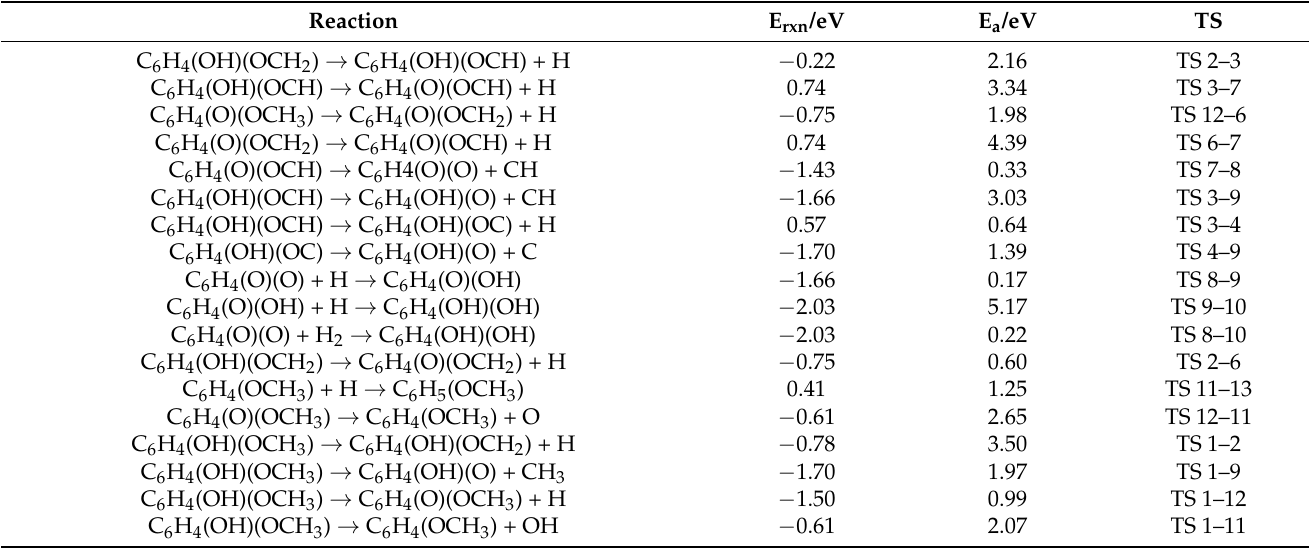
Figure 3. The four reaction paths (A, B, C, and D) and networks considered for the conversion of guaiacol to catechol and anisole. * indicates on the adsorbate, the sites of decomposition and radical formation. Table 1. Chemical equations for the elementary reaction steps involved in the HDO reaction of guaiacol, the transition state structures, and the single imaginary frequencies for the transition states on Cu